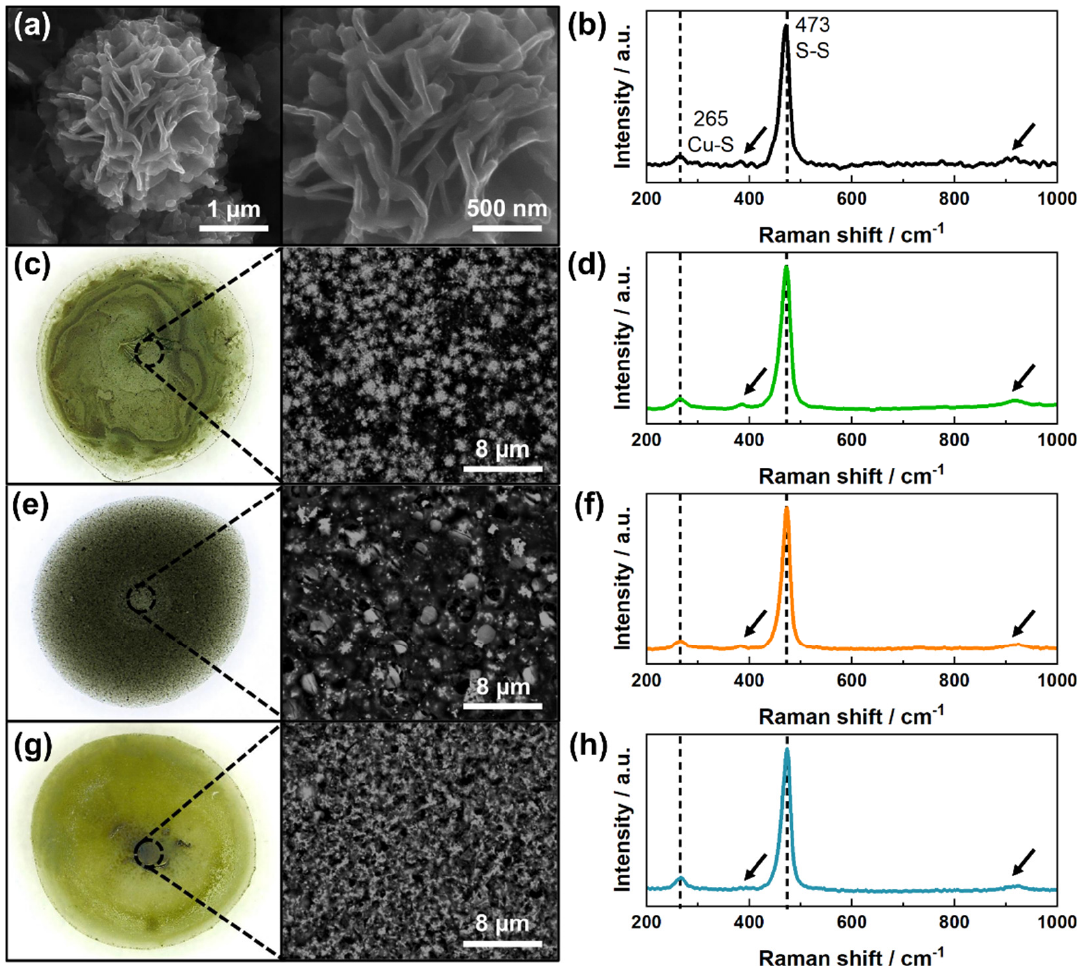
Figure 1. SEM images ( a , c , e , g ) and Raman spectra ( b , d , f , h ) of obtained copper sulfides ( a , b ) and Cu-CH ( c , d ), Cu-NAF ( e , f ), Cu-PVP ( g , h ) drop-casted layers. The arrows indicate the characteristic vibration modes for PVP-caped particles.